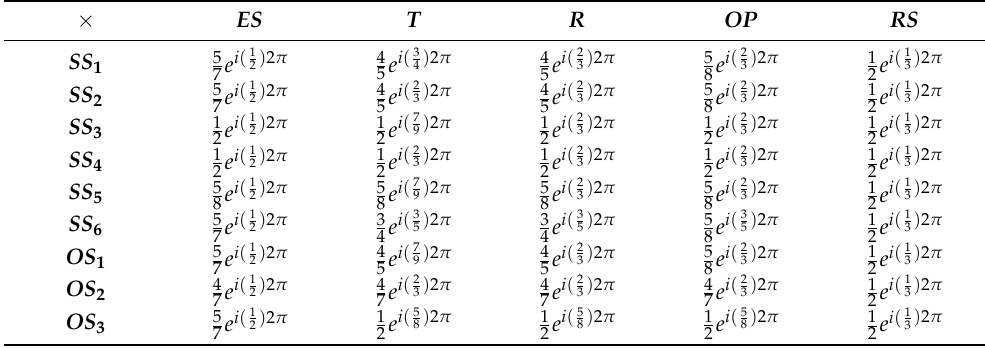
Table 7. Cartesian product S × A in a complex fuzzy environment.